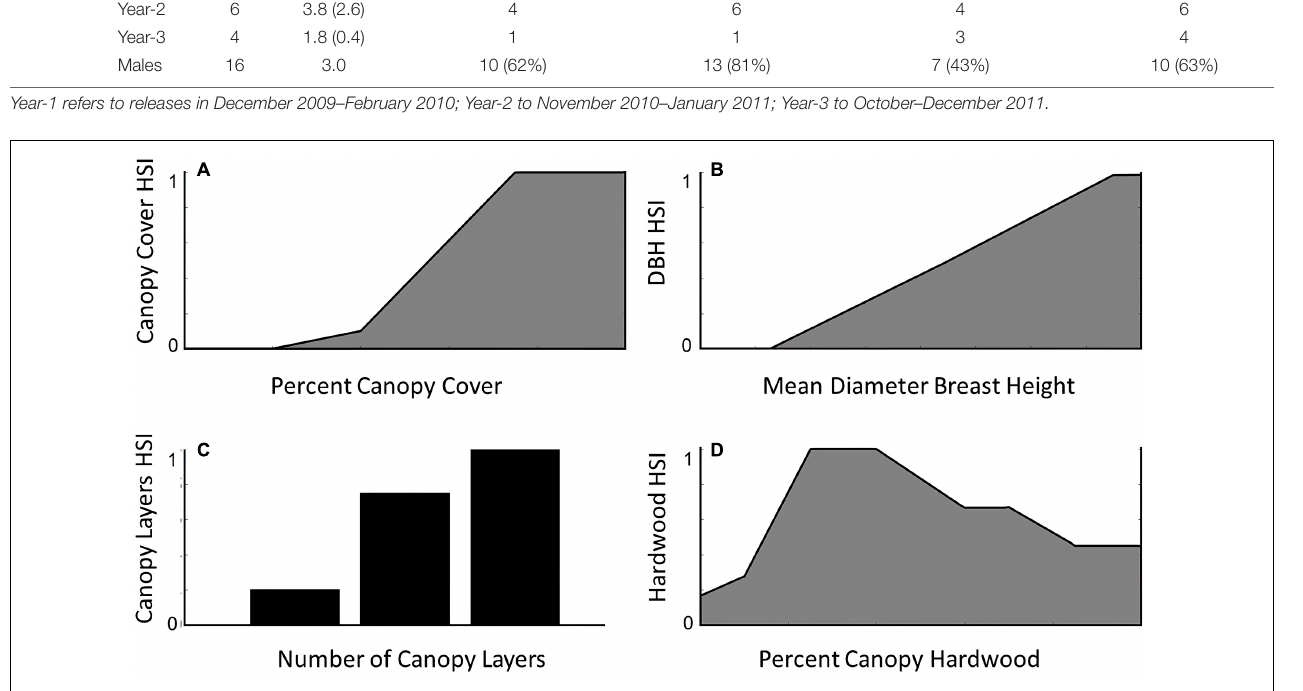
FIGURE 3 | The relationships between habitat suitability for fishers as derived from expert-opinion models and empirical assessment (model by Thomasma et al., 1994) and (A) percent canopy closure, (B) mean diameter at breast height (DBH) of overstory trees, (C) tree canopy diversity, and (D) percent of